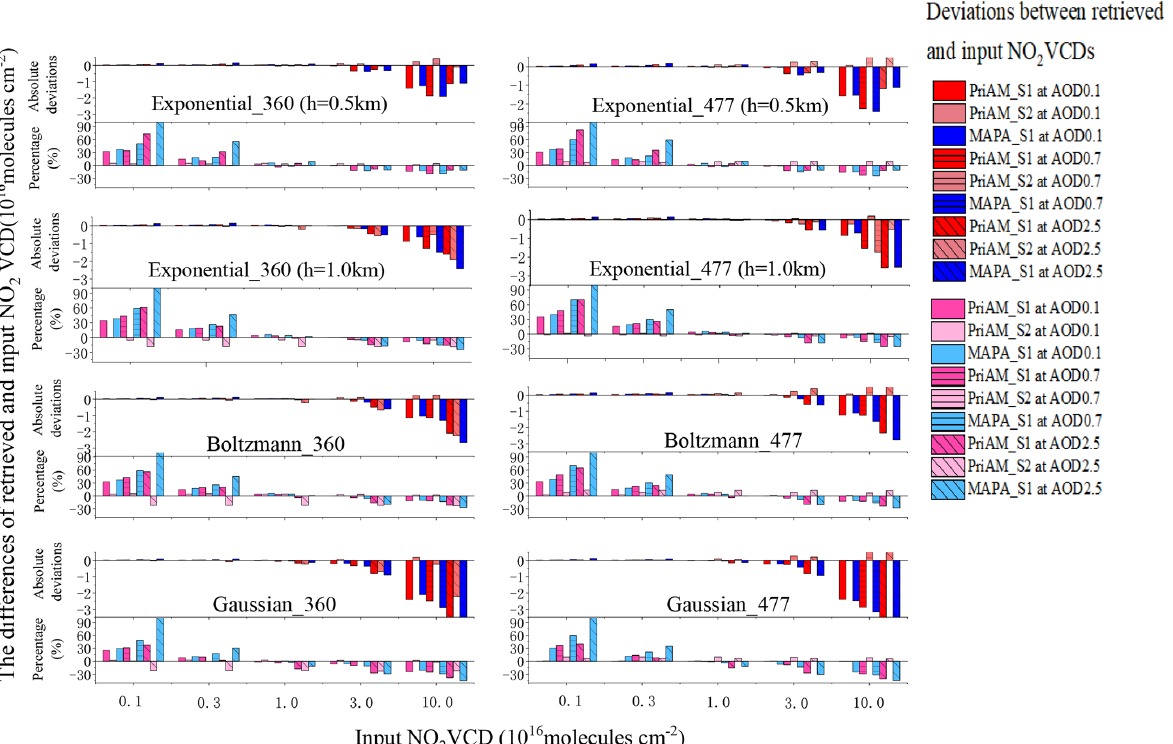
Figure 18. Absolute and relative deviations between the retrieved and input NO 2 VCDs for PriAM (S1 and S2) and MAPA (S1) for three AOD scenarios and five VCDs. The colors and shapes refer to the deviations of the retrieved and input NO 2 VCDs of the different algorithms at different AODs shown on the